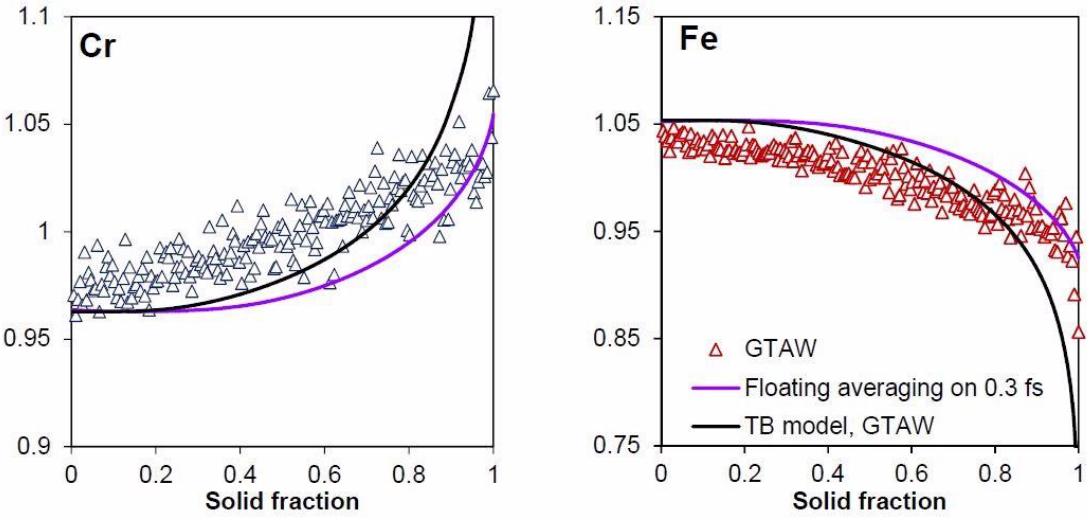
Figure 6. Comparison between the microsegregation profiles given by the TB model, and the TB model with floating averaging in the case of the GTAW experiments.